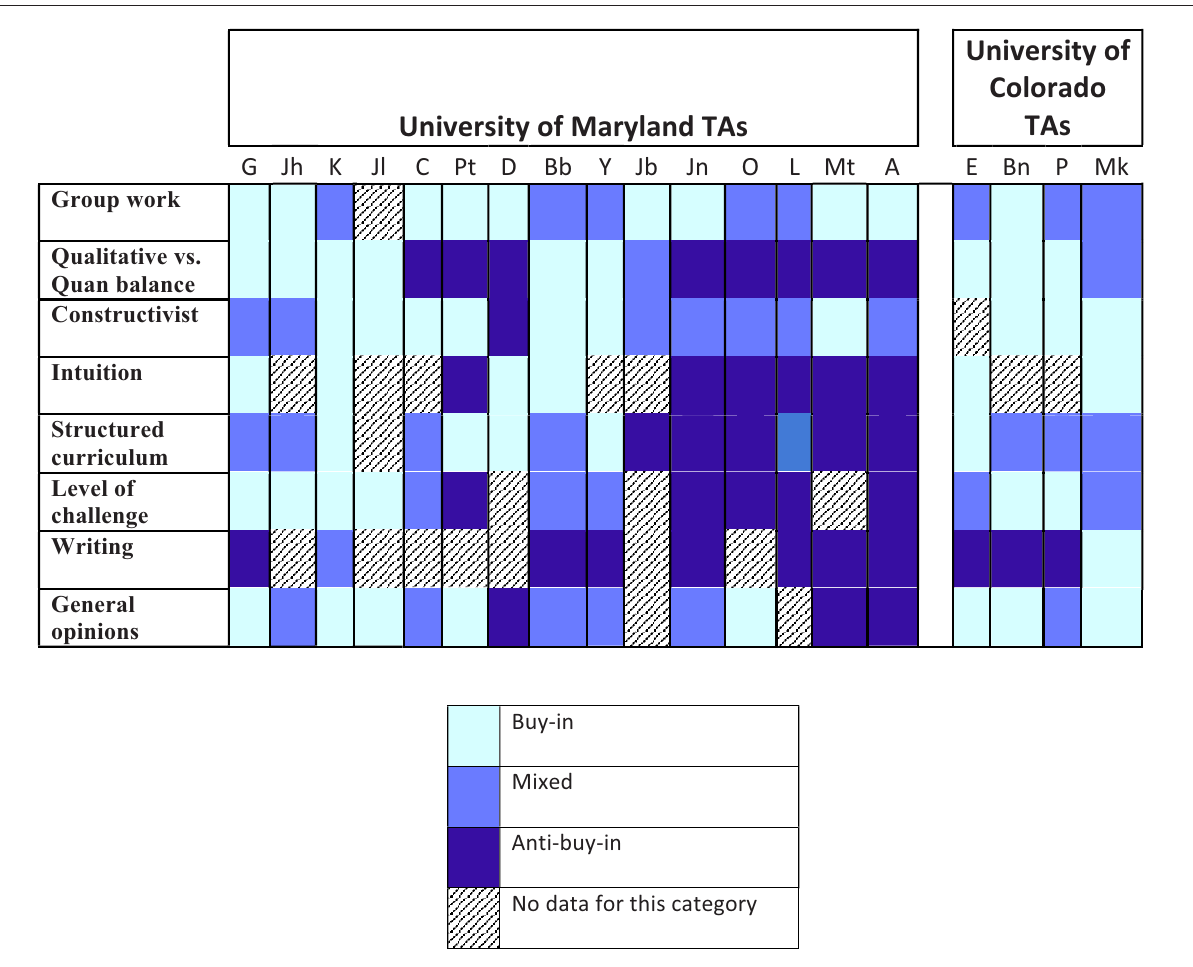
TABLE II. (cid:1) Color (cid:2) Designation each TA received in all of the categories on which he